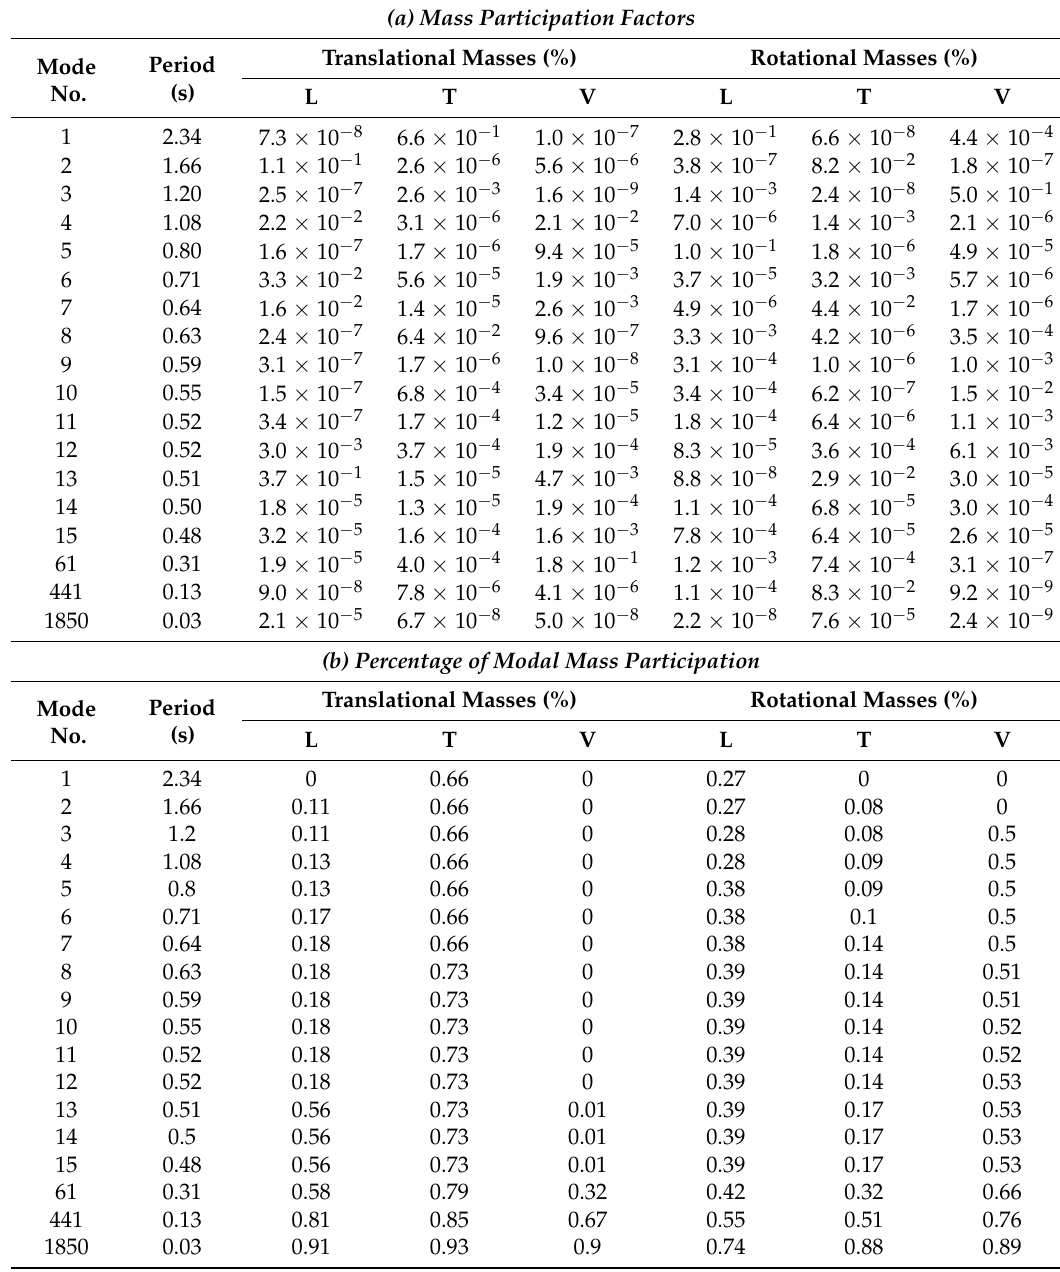
Table 1. Results of the free-vibration eigenvalue